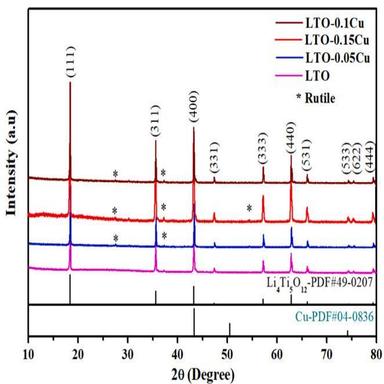
XRD patterns of the LTO-0.1Cu hybrid and its compared composites.